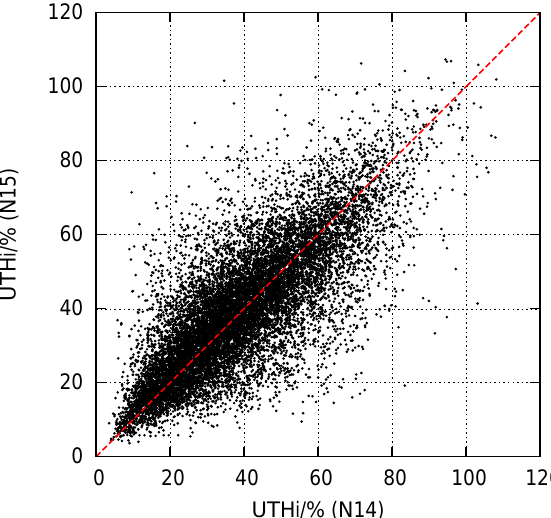
Figure 7. As Fig. 3, but with intercalibration via the cumulative dis- tribution function of brightness temperatures. This procedure leaves supersaturated cases in the N15 data set, and the scatter in the upper UTHi range appears more symmetric around the diagonal than in both Figs. 1 and 3.